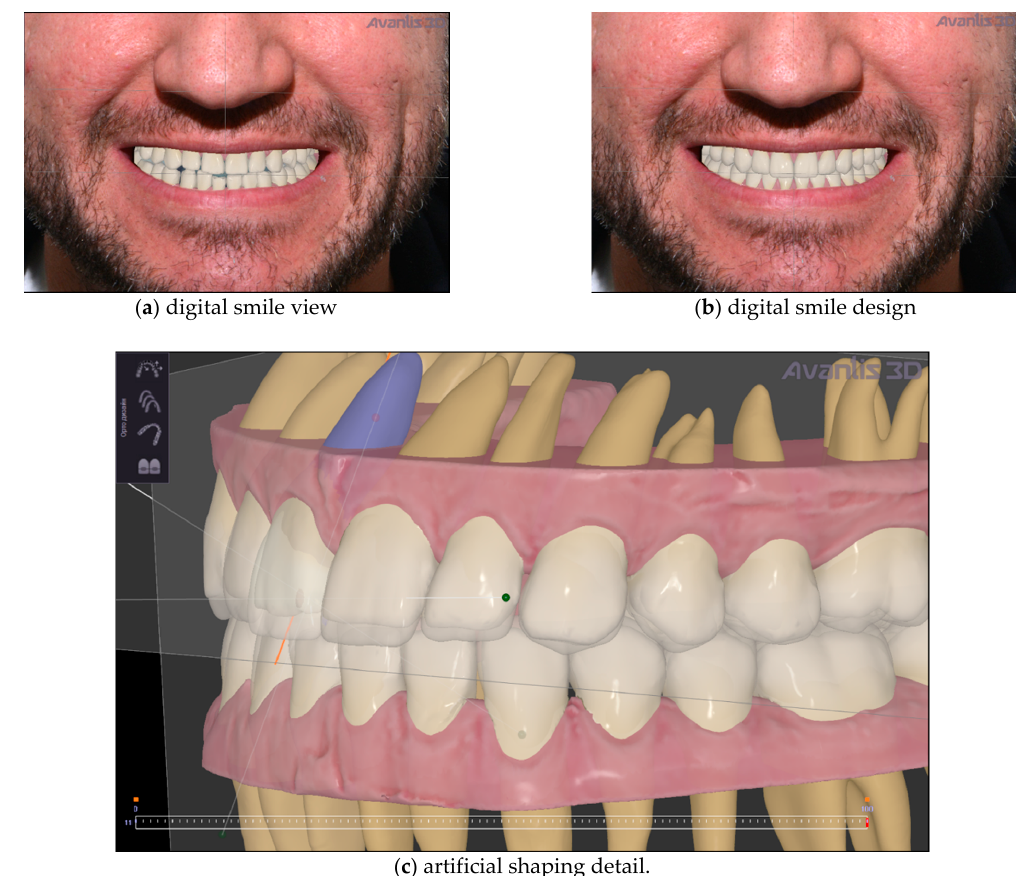
Figure 8. Artificial teeth setup. ( a ) digital smile view; ( b ) digital smile design ( c ) artificial shaping..